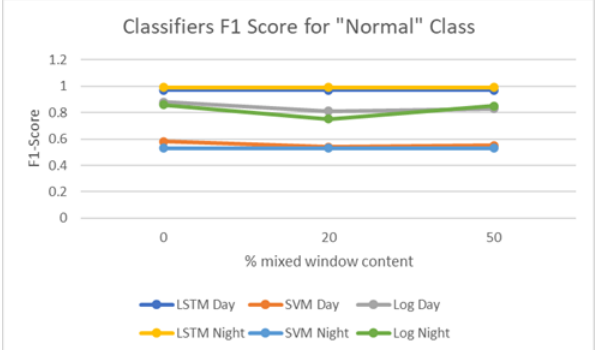
Figure 11. Comparison of ‘Normal Classification’ of our novel detection method with two other [13,23] state-of-the-art approaches proposed in the literature.